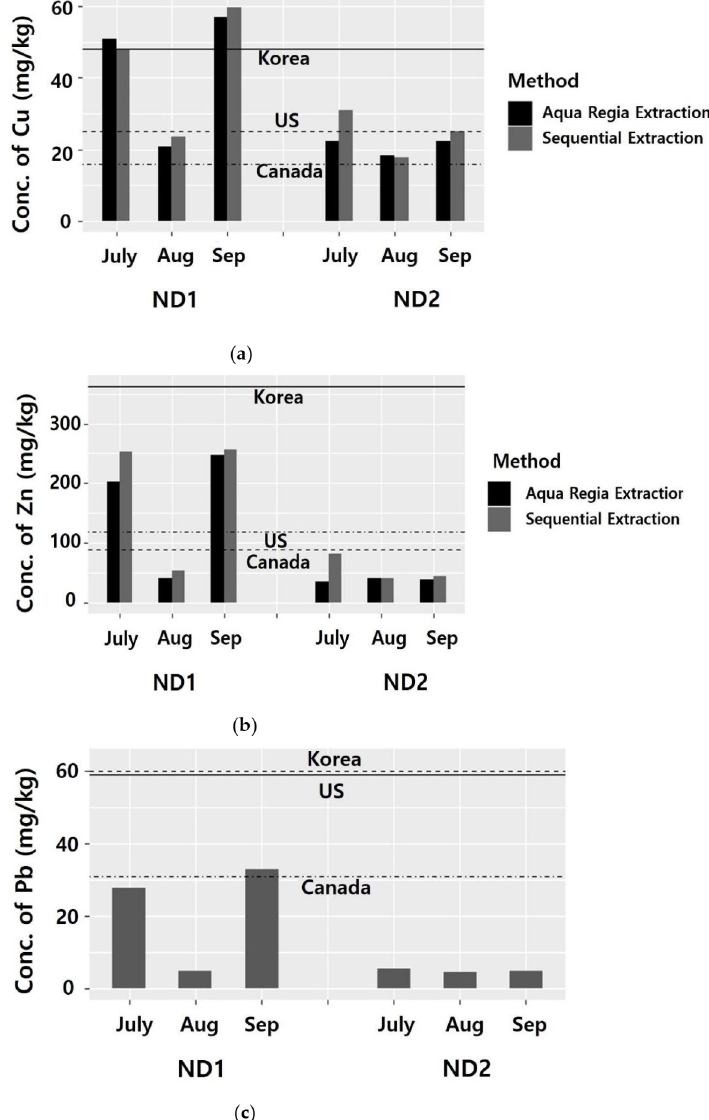
Figure 8. Sediment heavy metal standard of ( a ) Korea NIER, ( b ) Canada, and ( c ) US